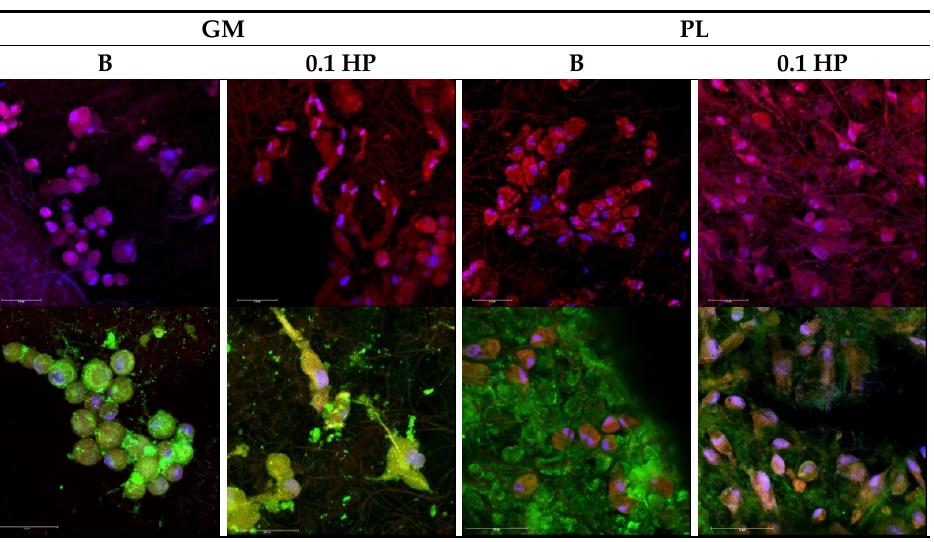
Figure 11. CLSM images of TEN-1 grown onto the aligned scaffolds (B and 0.1 HP) after 14 days with or without platelet lysate (PL) (PL 1:20 dilution in growth medium). Actin stained in red, nuclei stained in blue and collagen I stained in green (magnifications: 40 × upper row or 63 × lower